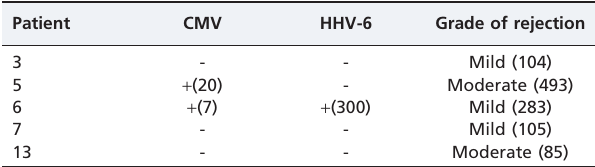
Table 2 - Patients who presented at least one episode of rejection during follow-up and episodes of CMV and/or HHV-6 active infection.